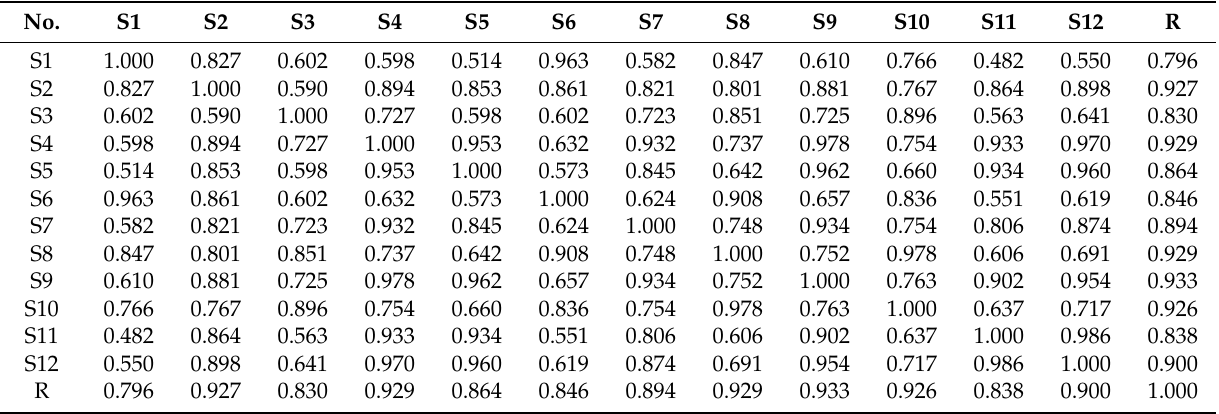
Table 2. The results of similarities of the chromatograms from different